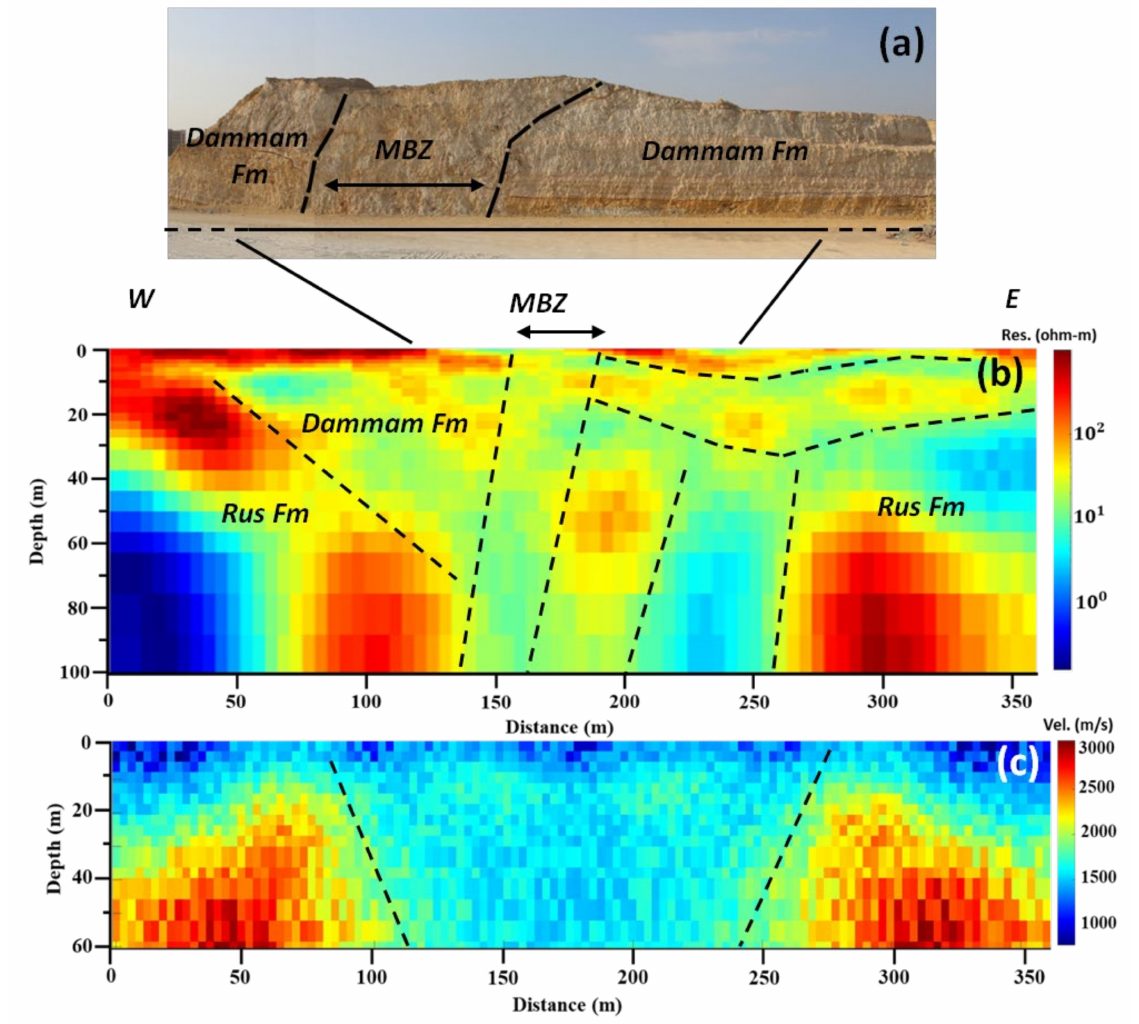
Figure 6. Structural interpretation of the resistivity and velocity models from profile 1: ( a ) section of the outcrop (road-cut) showing inclined strata; ( b ) interpreted resistivity model; and ( c ) interpreted velocity model. Notice that both methods (DCR and SR) map similar structures, especially the faults and the deformed zone. Both geophysical models are vertically exaggerated by